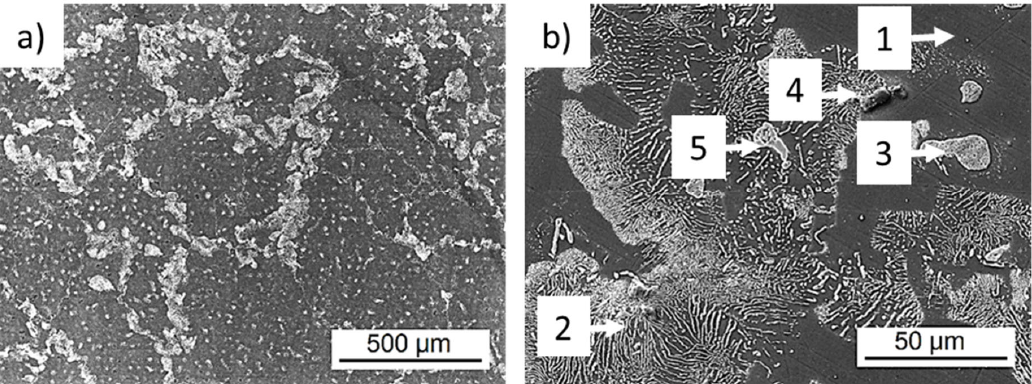
Figure 1. Microstructure of cast AZ91 magnesium alloy, etch; 2% Nital, SEM; ( a ) macro ‐ view of the cast microstructure; ( b ) detail of microstructural features. 1— γ –phase, 2—Mg 17 Al 12 discontinuous precipitate, 3—eutectic, 4—AlMn based intermetallic phase particle, 5—Mg 17 Al 12 intermetallic phase particle.